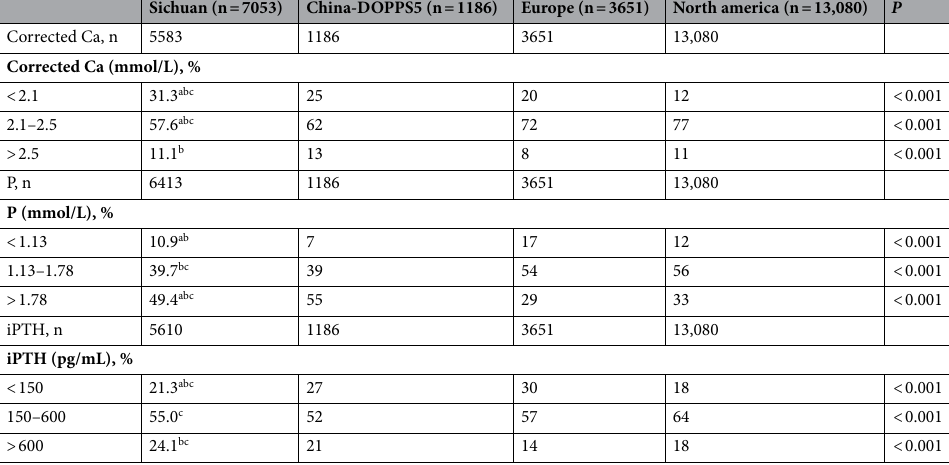
Table 2. Comparison of corrected Ca, P, and iPTH achievement rates with DOPPS5. a Sichuan compared with